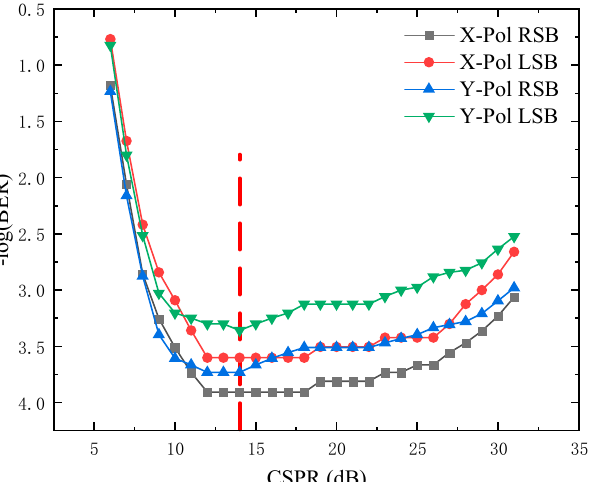
Figure 3. BER versus the CSPR for 8-Gbaud LSB and RSB of X-Pol and Y-Pol at the 16 dBm received optical power BTB transmission scenarios, respectively.